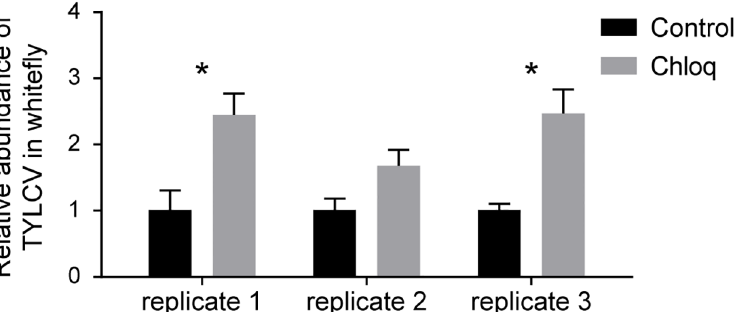
Fig 8. Inhibiting endosomal acidification increases TYLCV content in whitefly. Endosomal acidification was suppressed by feeding whiteflies with Chloq. Then, the whiteflies were allowed to feed on TYLCV-infected plants for 48 h. The abundance of virus in whiteflies was measured by quantitative PCR and compared with that in solvent-fed controls (n = 4). Data shown are mean ± SE. Statistically significant differences are indicated as: (cid:3) , P < 0.05; (cid:3)(cid:3) , P <